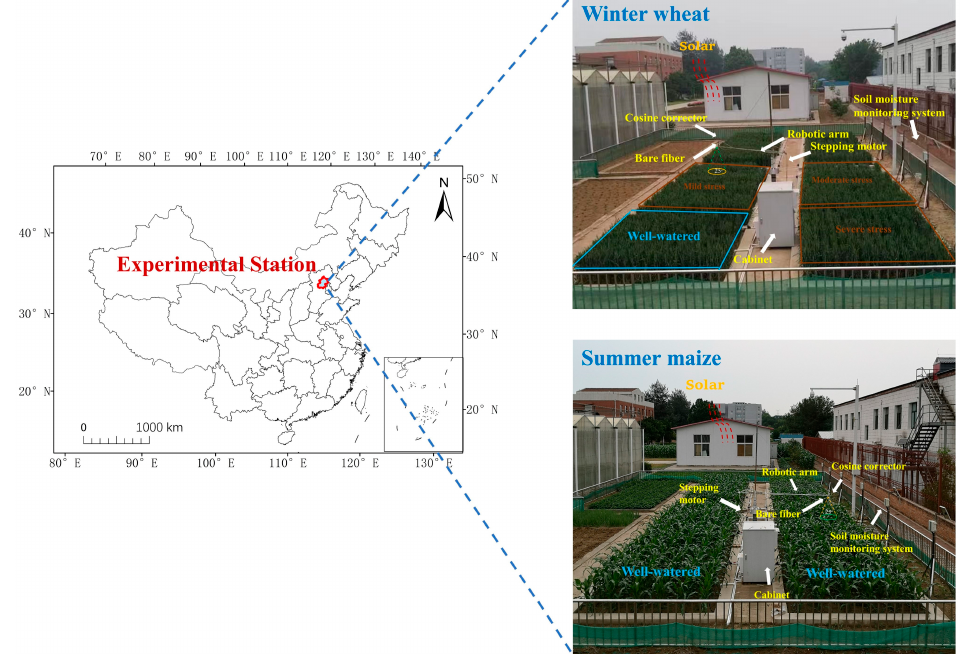
Figure 1. The location of the test site and the test area of winter wheat and summer maize.